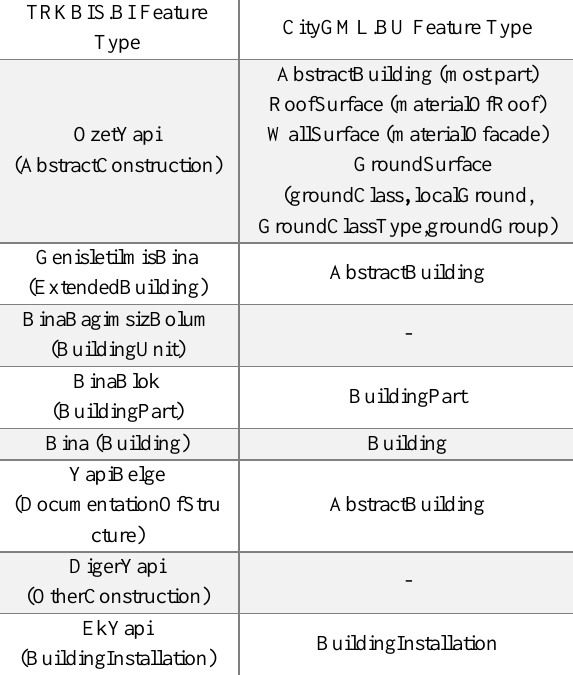
Table 1: Summary of mapping CityGML and TRKBIS-Building data